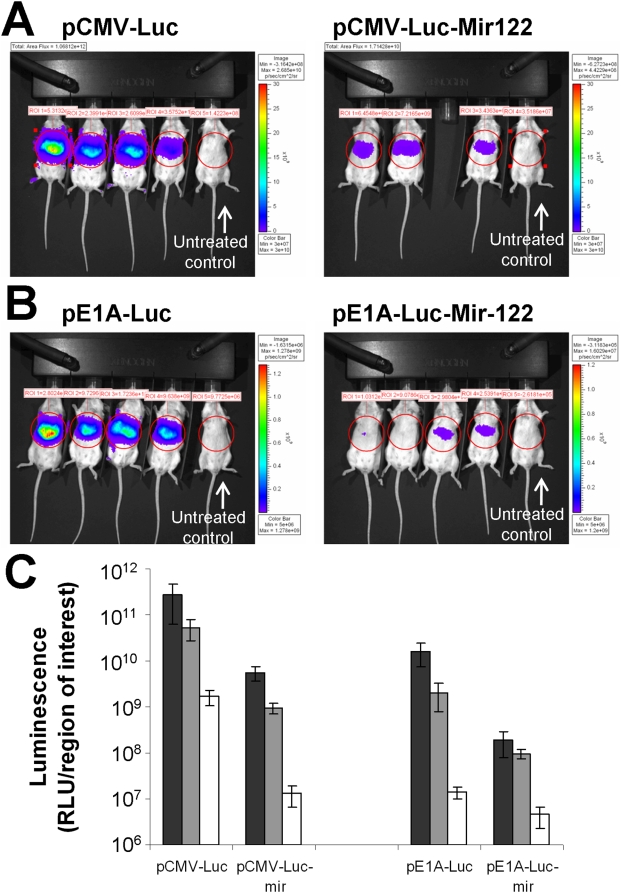
Effects of including binding sites for microRNA122a on expression of plasmids in vivo following hydrodynamic delivery to mice.(A) Imaging luminescence (8 h from mice administered pCMV-Luc not containing (left panel) and containing (right panel) four binding sites for mir-122 (plasmids pCMV-Luc and pCMV-Luc-mir in Figure 1).The animal on the right side of all images is a control treated with PBS, but mock injected with luciferin, used to provide a background reading. (B) Imaging luminescence (8 h from mice administered pE1A-Luc fusion constructs not containing (left panel) and containing (right panel) four binding sites for microRNA122a (plasmids pE1A-Luc and pE1A-luc-mir in Figure 1). The animal on the right is an untreated control. The two images in A are directly comparable with each other, as also the two images in B; however scaling is different between (A) and (B) in order to accommodate substantially different signal intensities from these plasmids. (C) Time course of luciferase expression from CMV promoter-driven and E1A promoter driven constructs shown in A and B. Black = 8 h, Grey = 24 h, White = 48 h. n = 4 throughout (except pCMV-Luc-mir122 where n = 3), error bars show standard deviation.